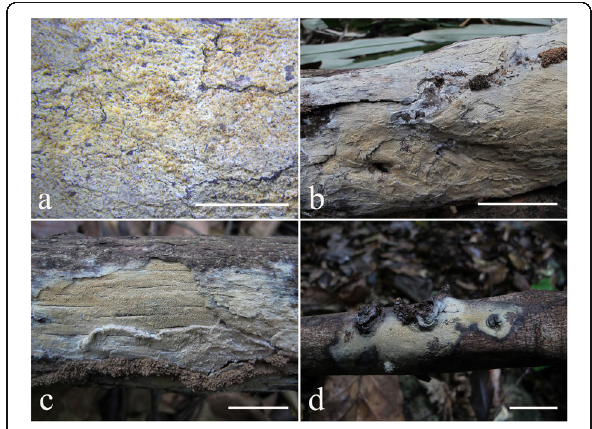
Fig. 6 Basidiomes of Resinicium lateastrocystidium . a , b LWZ 20180414-15 (holotype). c LWZ 20180414-13 (paratype). d LWZ 20180416-10 (paratype). Scale bars: a = 5 mm, b – d = 2 cm